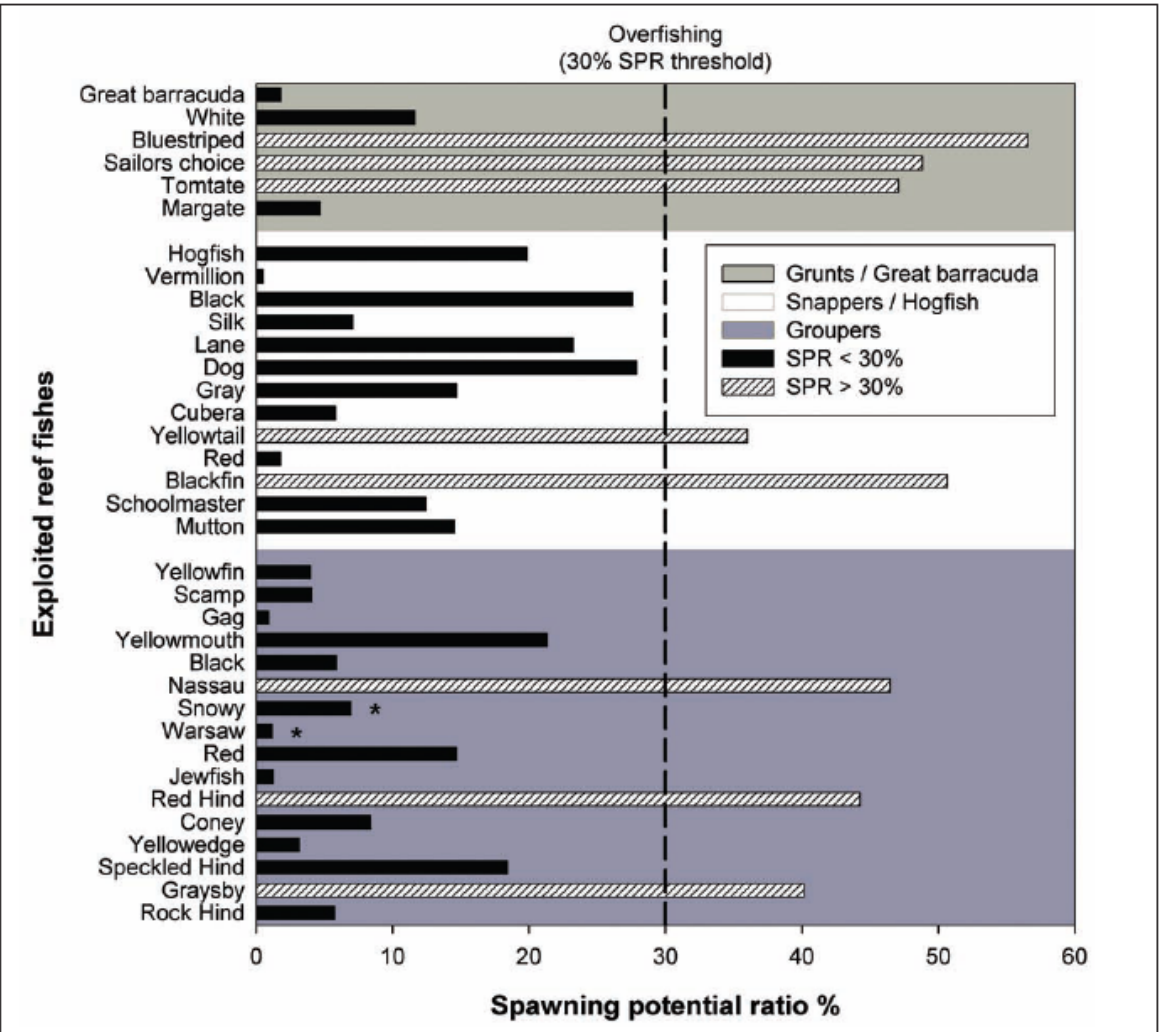
Figure 2. Spawning potential ratio for reef fish for 35 species from Biscayne National Park-Florida Keys. Bars that are less than 30% (black bars) indicate overfished species, those that are more than 30% (striped bars) are not overfished. Notice the wide variation from one species to another. Reproduced from [210], derived from